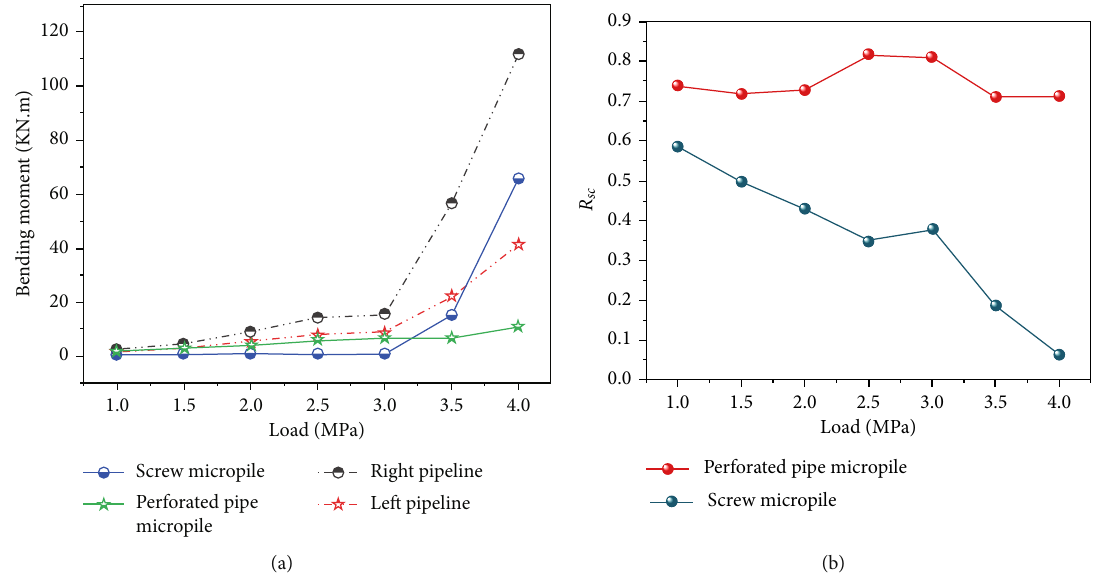
Figure 17: Bending moment variation of micropile-pipeline (a) and sliding e ff ect coe ffi cient of micropile-pipeline